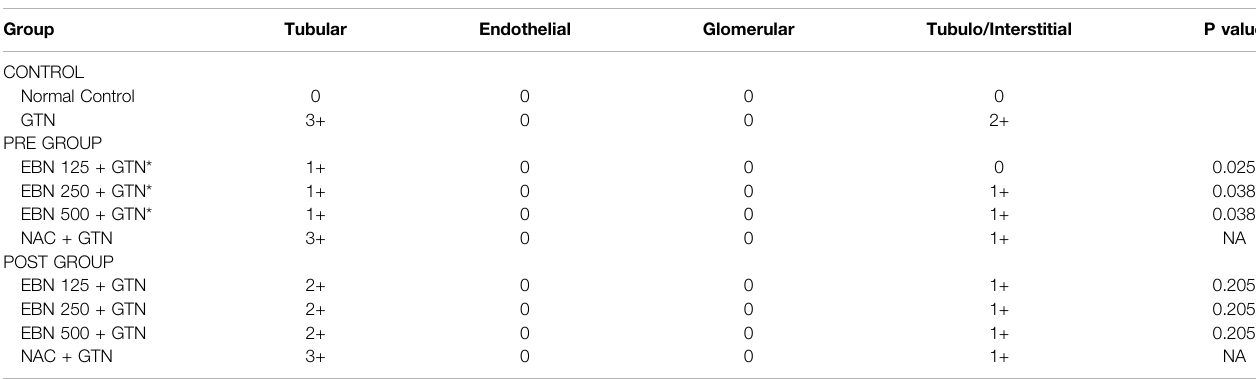
TABLE 1 | The EFTI scoring system for